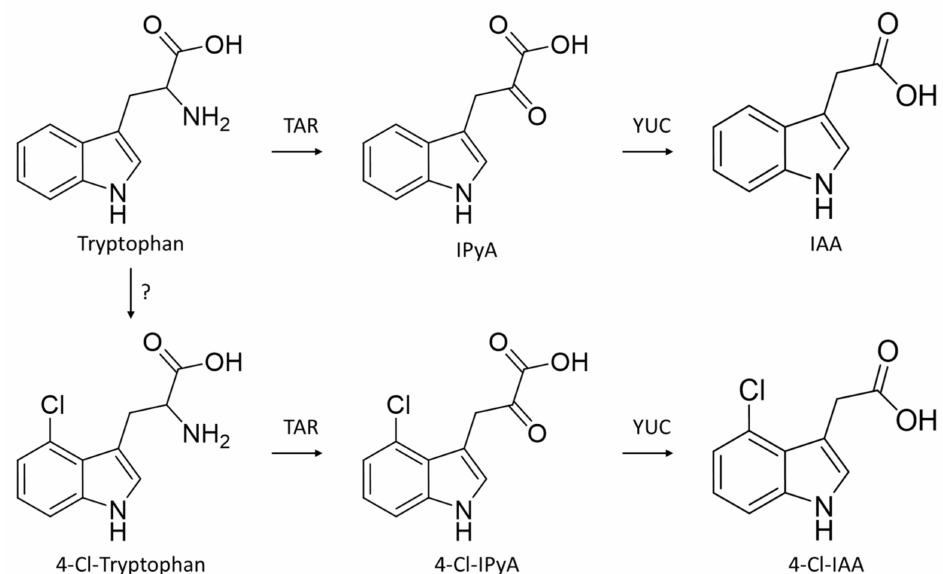
Figure 2. Biosynthesis of auxin and 4 (cid:48) position chlorinated auxin in pea. Enzyme responsible for halogenation of tryptophan is unknown. IPyA, indole pyruvic acid; 4-Cl-IPyA, 4-chlorinated indole pyruvic acid; IAA, indoleacetic acid; 4-Cl-IAA, 4-chloroindole acetic acid. Schema based on results from